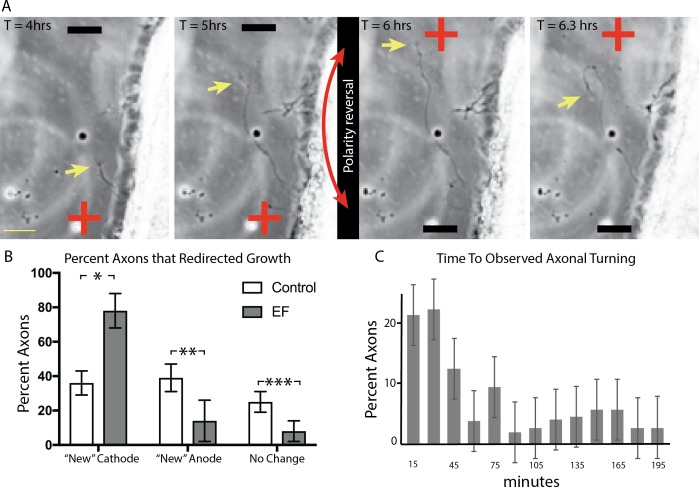
RGC axons change direction of growth in response to reversal in EF polarity. (A) Retinal explants were grown overnight, then exposed to an EF of 100 mV/mm for 6 hours, after which polarity was reversed by 180°. Explants were then monitored for 6 more hours. An axon can be seen reversing its direction of growth within a single time frame (20 minutes) of switching EF polarity. Also see Supplementary Video S1. (Yellow arrow points to representative growth cone.) (B) Explants were grown overnight, then exposed to an EF of 200 mV/mm for 4 hours. The polarity of the EF was then reversed by 180° and cultures were observed for another 4 hours. The percent of axons seen redirecting their growth after the EF switch toward the “new” cathode, “new” anode, versus no reaction was quantified (see Methods). Results demonstrate that significantly more axons redirected their growth toward the “new” cathode than random turns seen in culture. (*P < 0.001; **; ***P < 0.05; 2-way ANOVA). (C) Of the axons that redirected their growth toward the “new” cathode in (B), the number of time frames that had elapsed since the EF switch and this change in direction of growth could be observed was tallied and recorded. Error bars represent SD. Yellow scale bar: 25 μm.